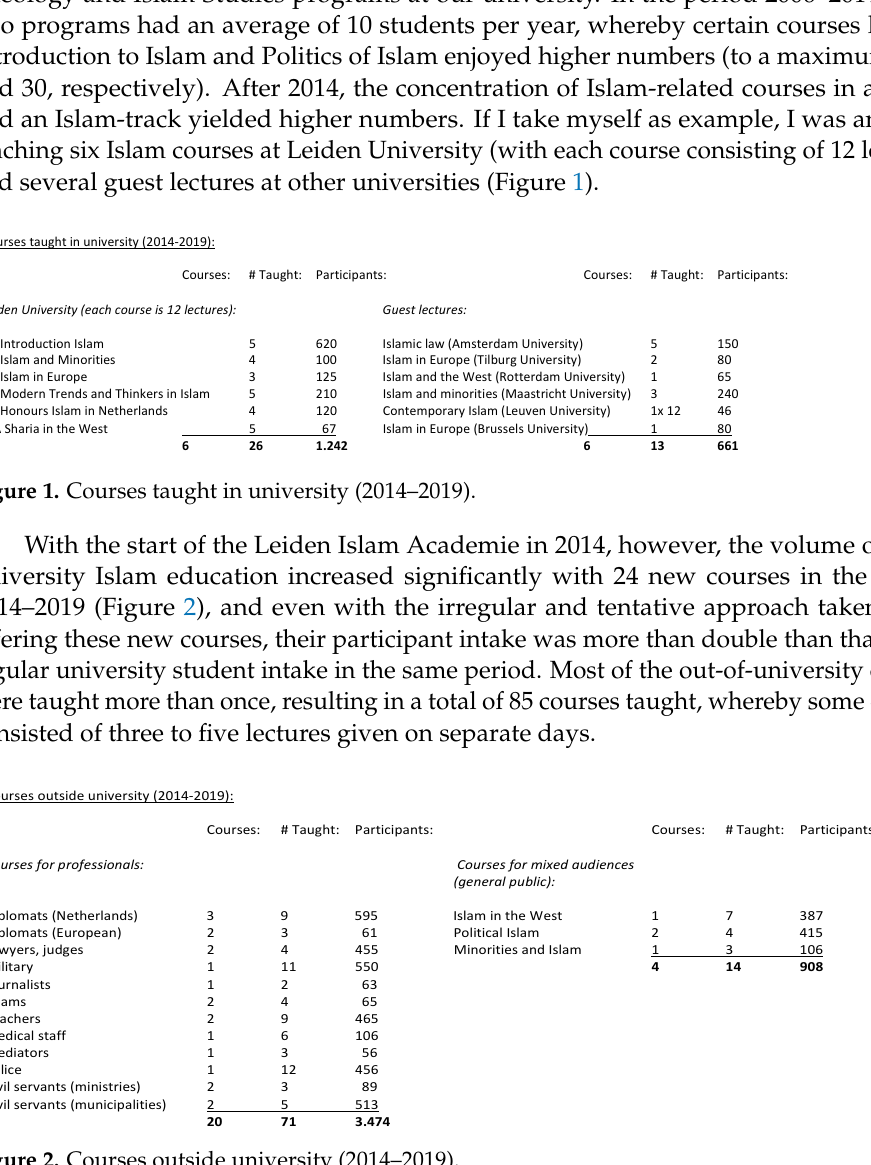
Figure 2. Courses outside university (2014–2019).